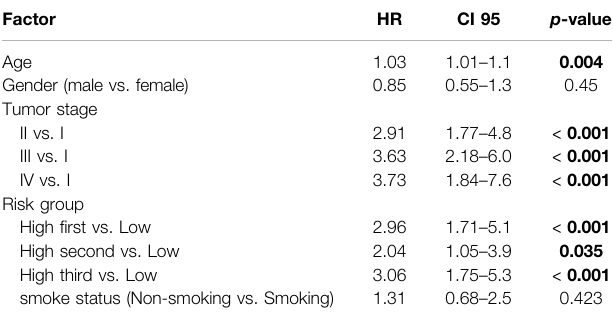
TABLE 2 | Multivariate Cox analysis of clinical characteristics and risk groups.